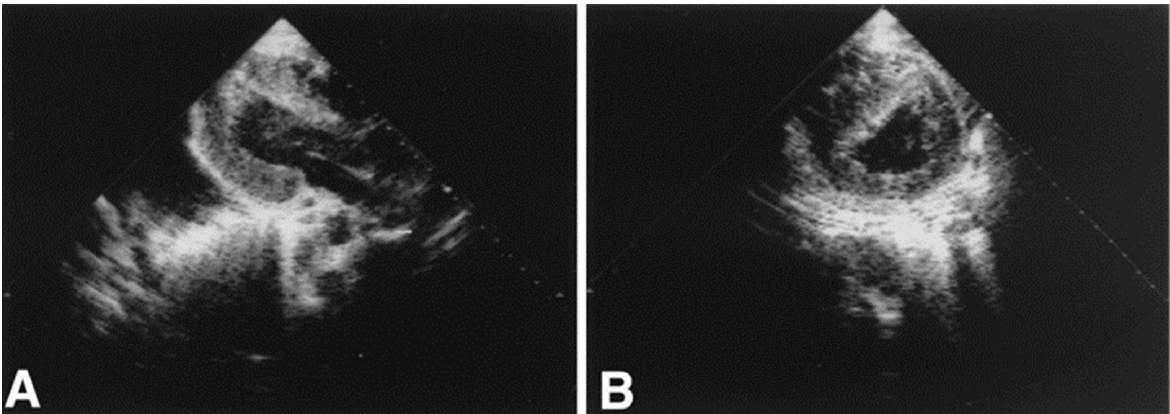
Figure 1. Two-dimensional echocardiograms from a 20-year-old man who presented after five days of a viral syndrome with acute fulminant myocarditis and acute hemodynamic collapse. The panels show parasternal long-axis ( A ) and short-axis ( B ) views. There is severe ventricular thickening (septal thickness 2.1 cm) but small ventricular cavity size (LVEDD 2.5 cm). The patient recovered with near-normal left ventricular function after hemodynamic support with intravenous inotropic agents and a left ventricular assist device. From Felker, G.M.; Boehmer, J.P.; Hruban, R.H.; et al. Echocar- diographic findings in fulminant and acute myocarditis. J. Am. Coll. Cardiol . 2000 , 36 , 227–232. Re- printed with permission from Elsevier [20]. Table 1. Conventional echocardiography in viral myocarditis.